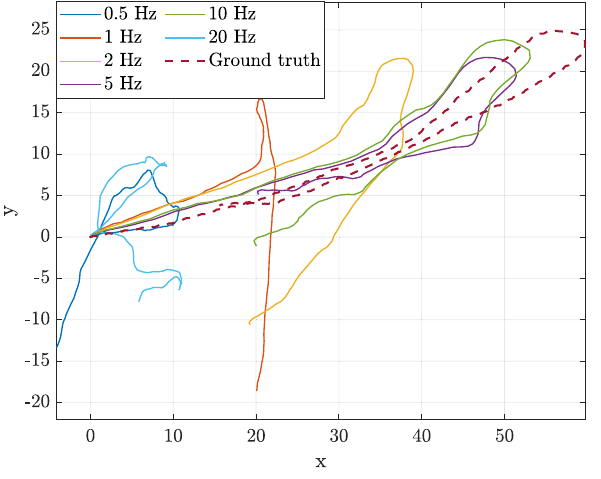
Fig. 10 Comparison between laser-based ICP and ground truth tra- jectories, at different data rates